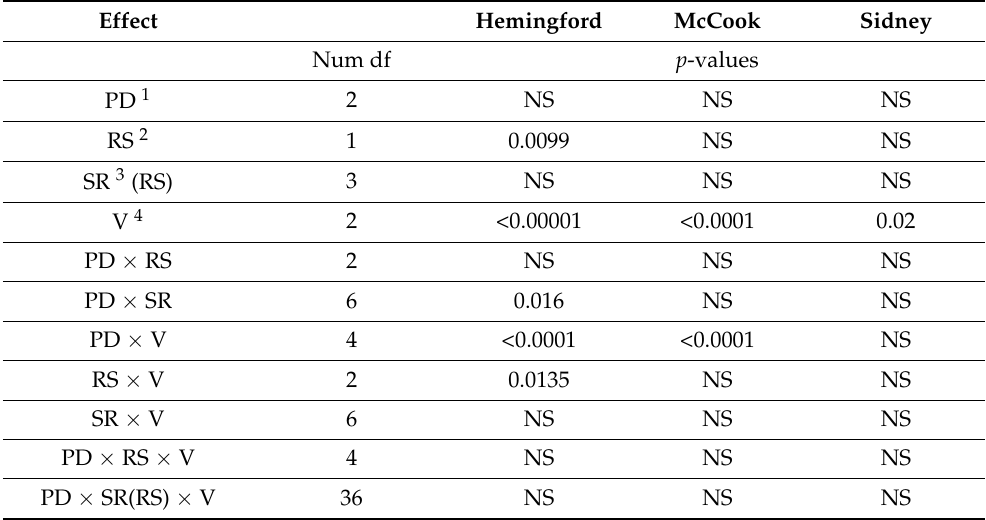
Table 2. Analysis of variance showing the effect of planting date, row spacing, seeding rate, variety, and their interactions on winter wheat grain yield. Effect